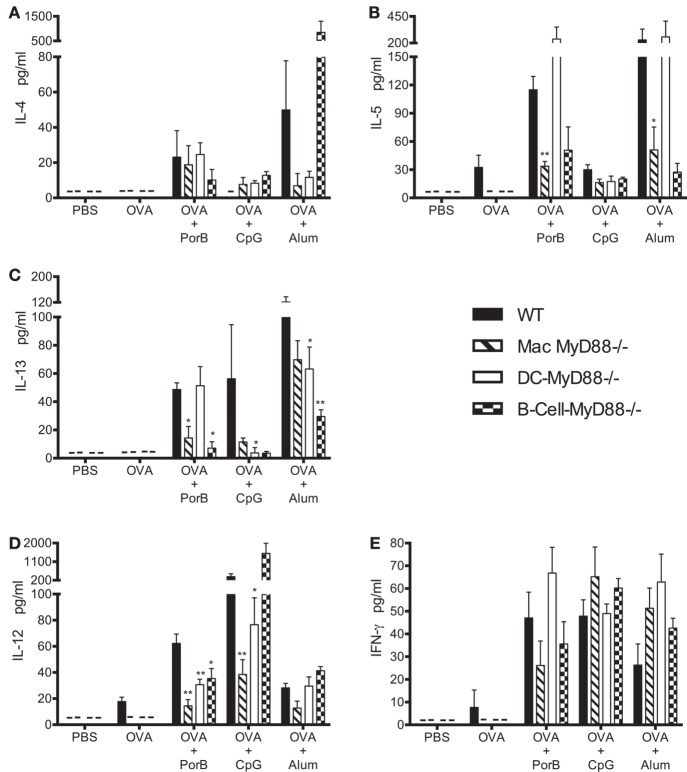
In vivo MyD88 signaling in macrophages differentially affects the induction of Th2 and Th1 type cytokines upon immunization with toll-like receptor ligand-based adjuvants. (A–C) Th2 type (IL-4, IL-5, and IL-13) and (D,E) Th1 type (IL-12 and IFN-γ) cytokines level in individual mouse serum of wild-type (WT), Mac-MyD88−/−, B-cell-MyD88−/−, and DC-MyD88−/− mice immunized two times at 2 weeks interval and serum collected 4 h after of the second immunization with PBS, ovalbumin (OVA), OVA + PorB, OVA + CpG, or OVA + alum measured by Luminex magnetic bead-based multiplex assay. The results shown are representative of one experiment (n = 4 mice); serum was analyzed individually in duplicates. This experiment was repeated twice. Symbol (–) indicates that cytokine levels were below detectable level. One-way ANOVA with Tukey’s test were used to calculate statistical differences between experimental groups and treatments (ns, not significant P > 0.05, *P < 0.05, **P < 0.01). All comparisons were made to WT mice.